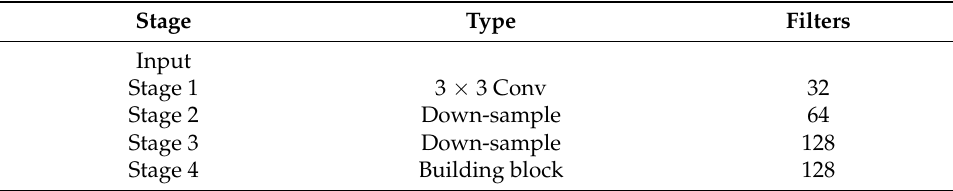
Table 2. SEM is used to extract high-level semantic information.